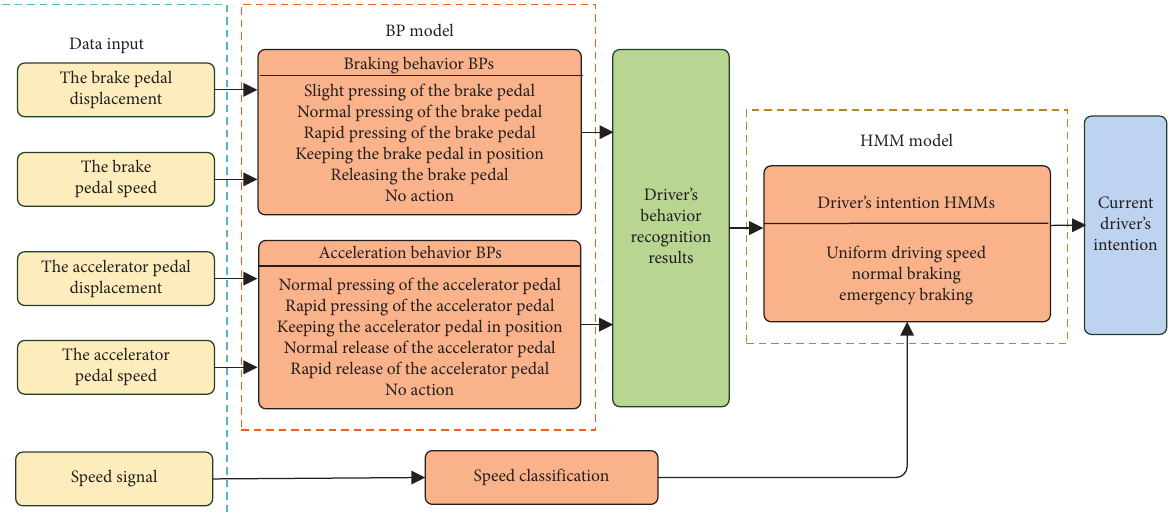
Figure 2: Structure of the proposed BP-HMM model.